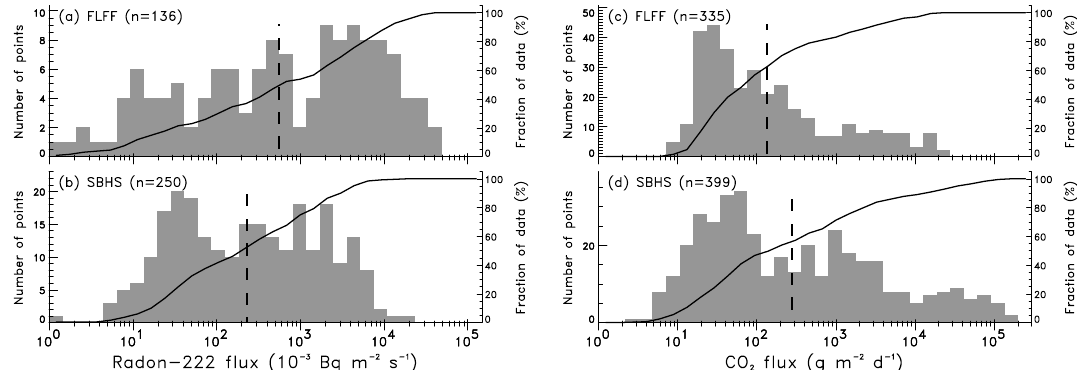
Figure 2. Distributions of radon and CO 2 fluxes measured at both sites (in logarithmic scale): on the left, radon flux at (a) FLFF and (b) SBHS; on the right, CO 2 flux at (c) FLFF and (d) SBHS. Geometric mean of each distribution is represented as a vertical dashed black line and the cumulated distribution as a solid black curve (scale on the right-hand side).